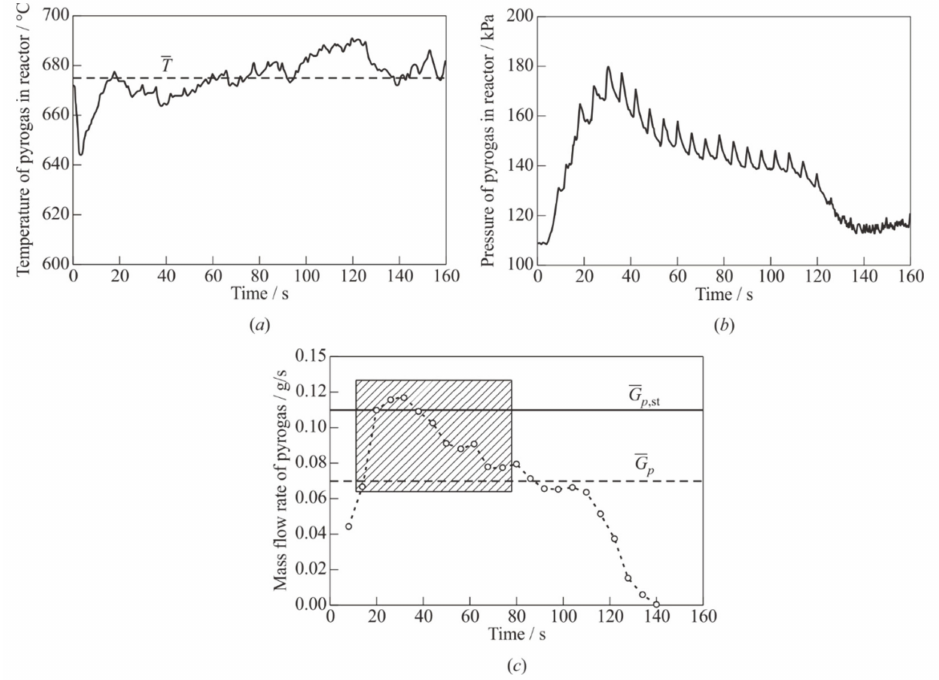
Figure 6. Measured time histories of pyrogas temperature ( a ) and pressure ( b ) and the calculated time histories of the PDT shot-averaged consumption of pyrogas ( c ) in an experiment with T p = 765 ◦ C and m 0 = 10